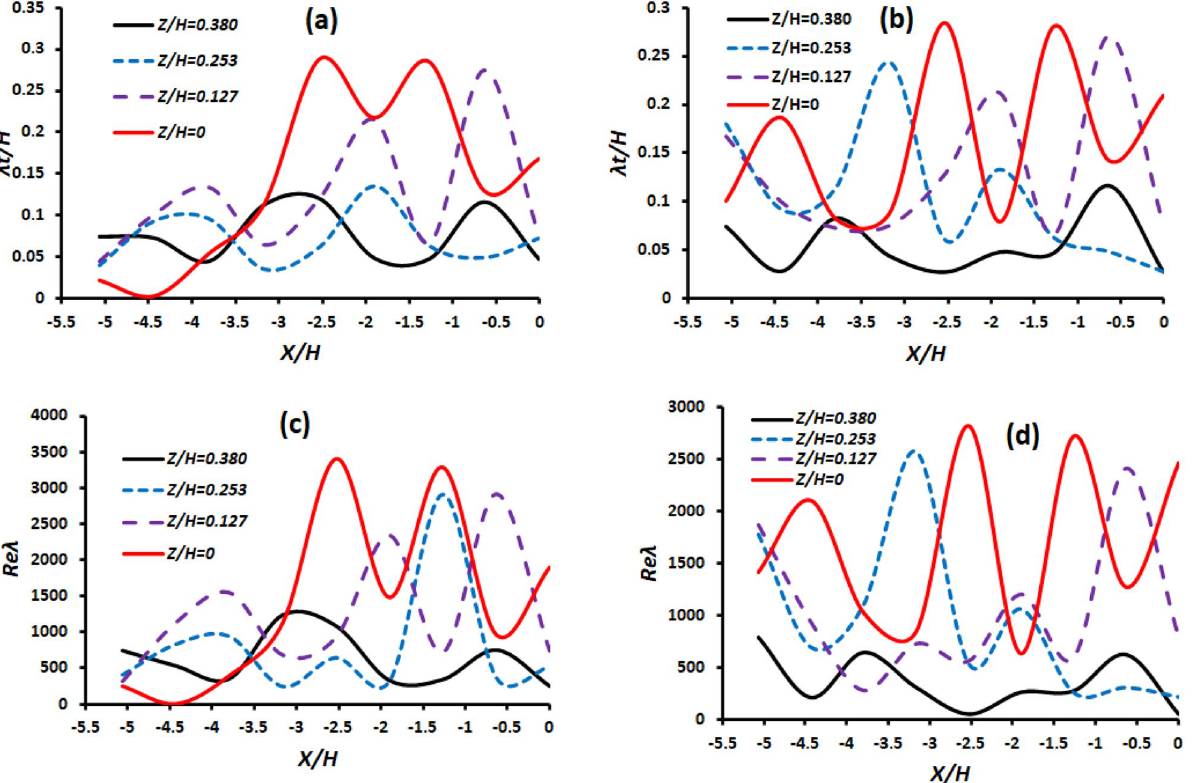
Figure 16. Plots of the normalized Taylor microscale (Upstairs) and Taylor-scale Reynolds number (Downstairs) against X/H at different Z/H and Y/H = 0: ( a and c ) Trawl net without catch, and ( b and d ) Trawl net with